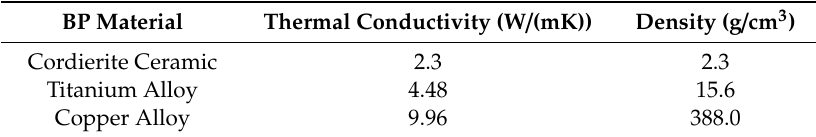
Table 1. Thermal conductivity and density of backing plate (BP) materials.